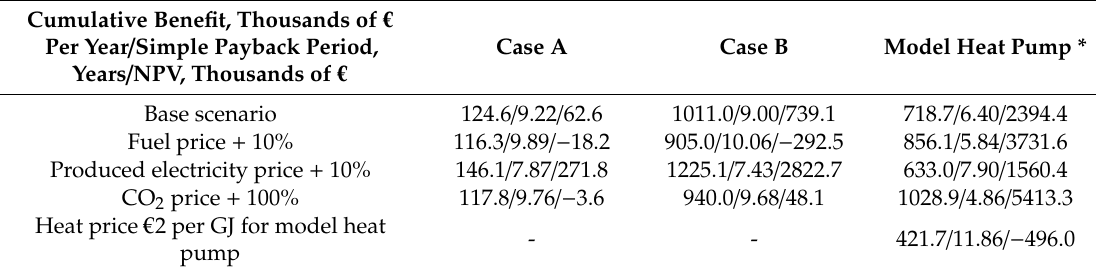
Table 12. Sensitivity analysis and simple payback period and net present value (NPV) values.